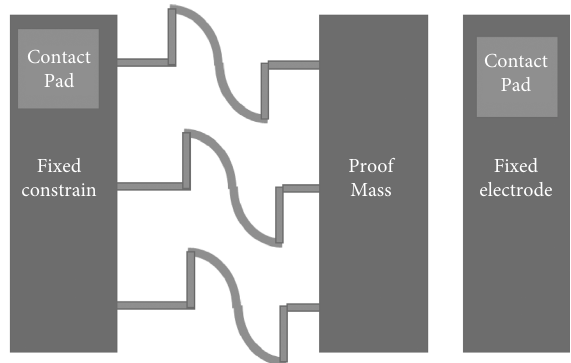
Figure 4: Proposed inertial sensor 4 with three sets of arc beams.